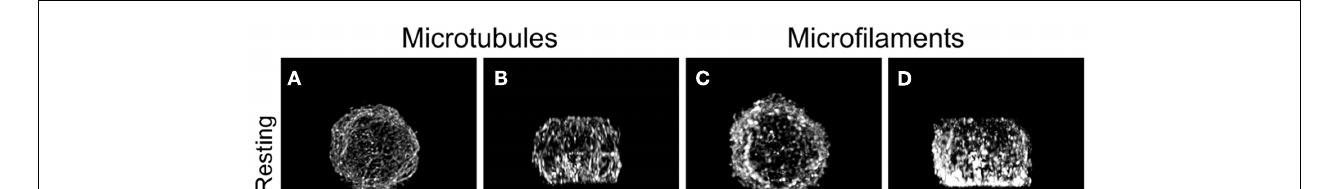
FIGURE 4 | Distribution of microtubule proteins in RBL-2H3 cells. In resting RBL-2H3 cells, microtubules, formed by αβ -tubulin dimers (A,D) originate from centrosomes where the γ -tubulin is concentrated (B) . Growing microtubules are marked by plus-end tracking protein EB1 (E) . Cells were fixed with cold methanol before staining with rabbit antibody to α -tubulin dimer [ (A,D) ; green fluorescence], mouse